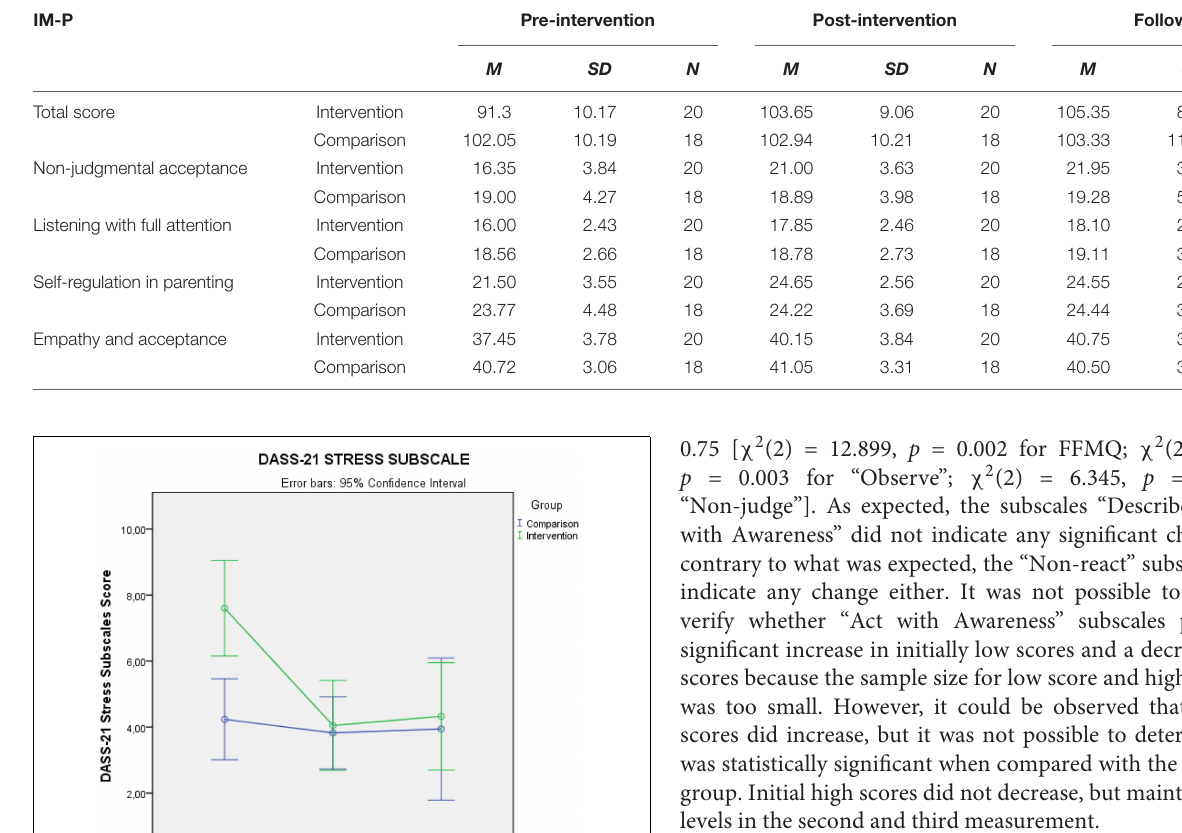
representation of mean changes in IM-P total scores and